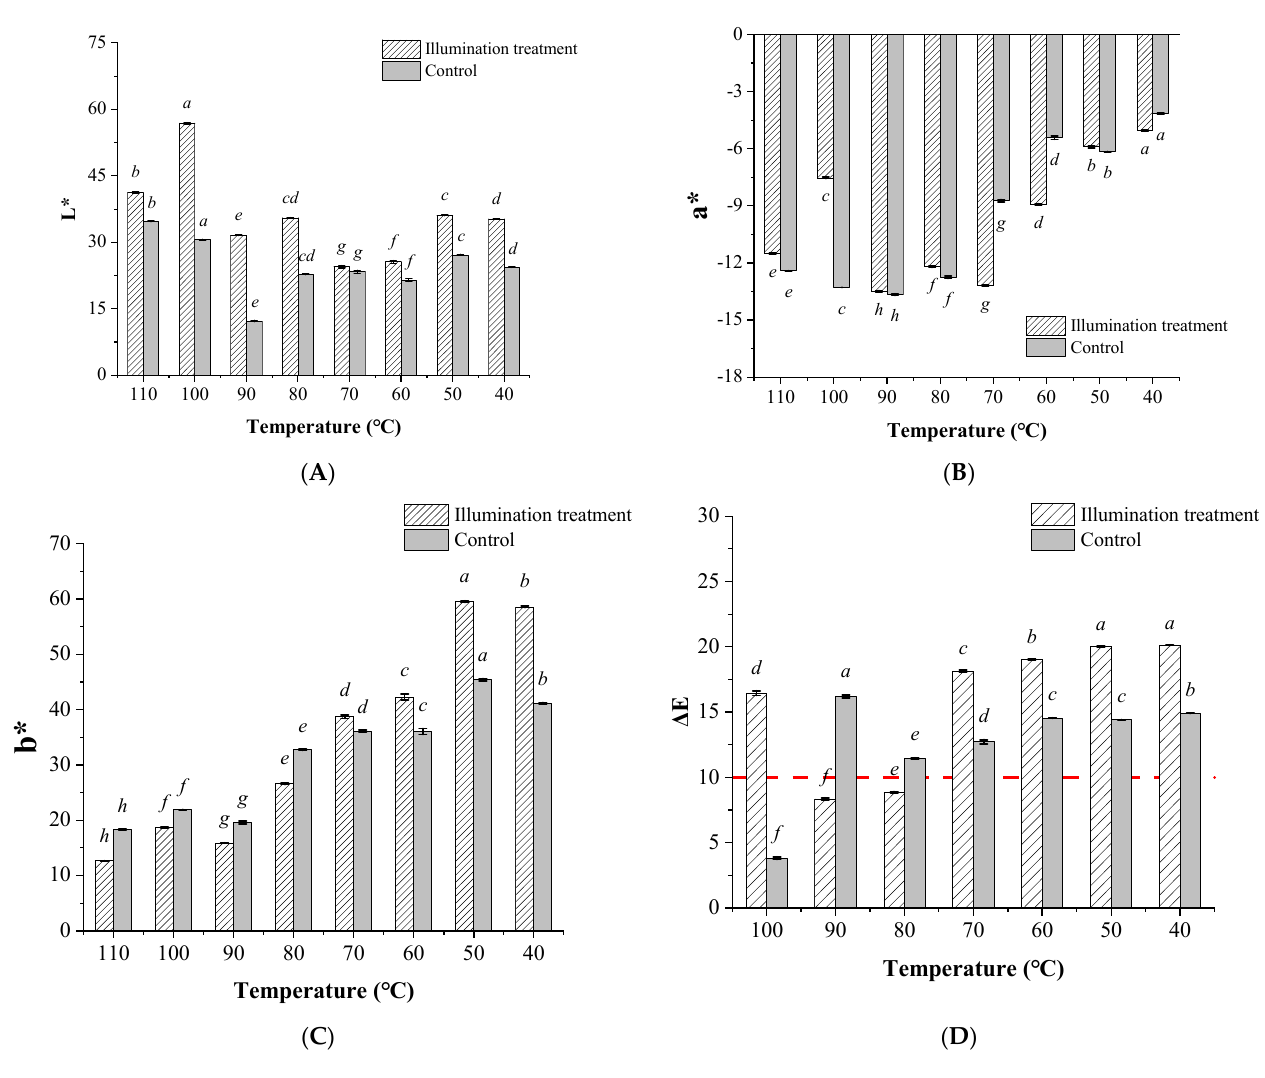
Figure 4. Color index (L*, a*, b*) ( A – C ) and the color-difference index ( Δ E 00 ) ( D ) of the bleached soybean oil (illumination pretreated groups and control group) under different bleaching temperatures. The data with different lowercase letters in the groups treated with different activated clay bleaching temperatures indicate significant difference under p < 0.05.